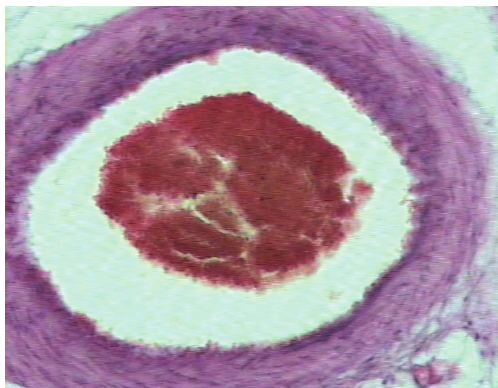
Figure 4: Intraluminal